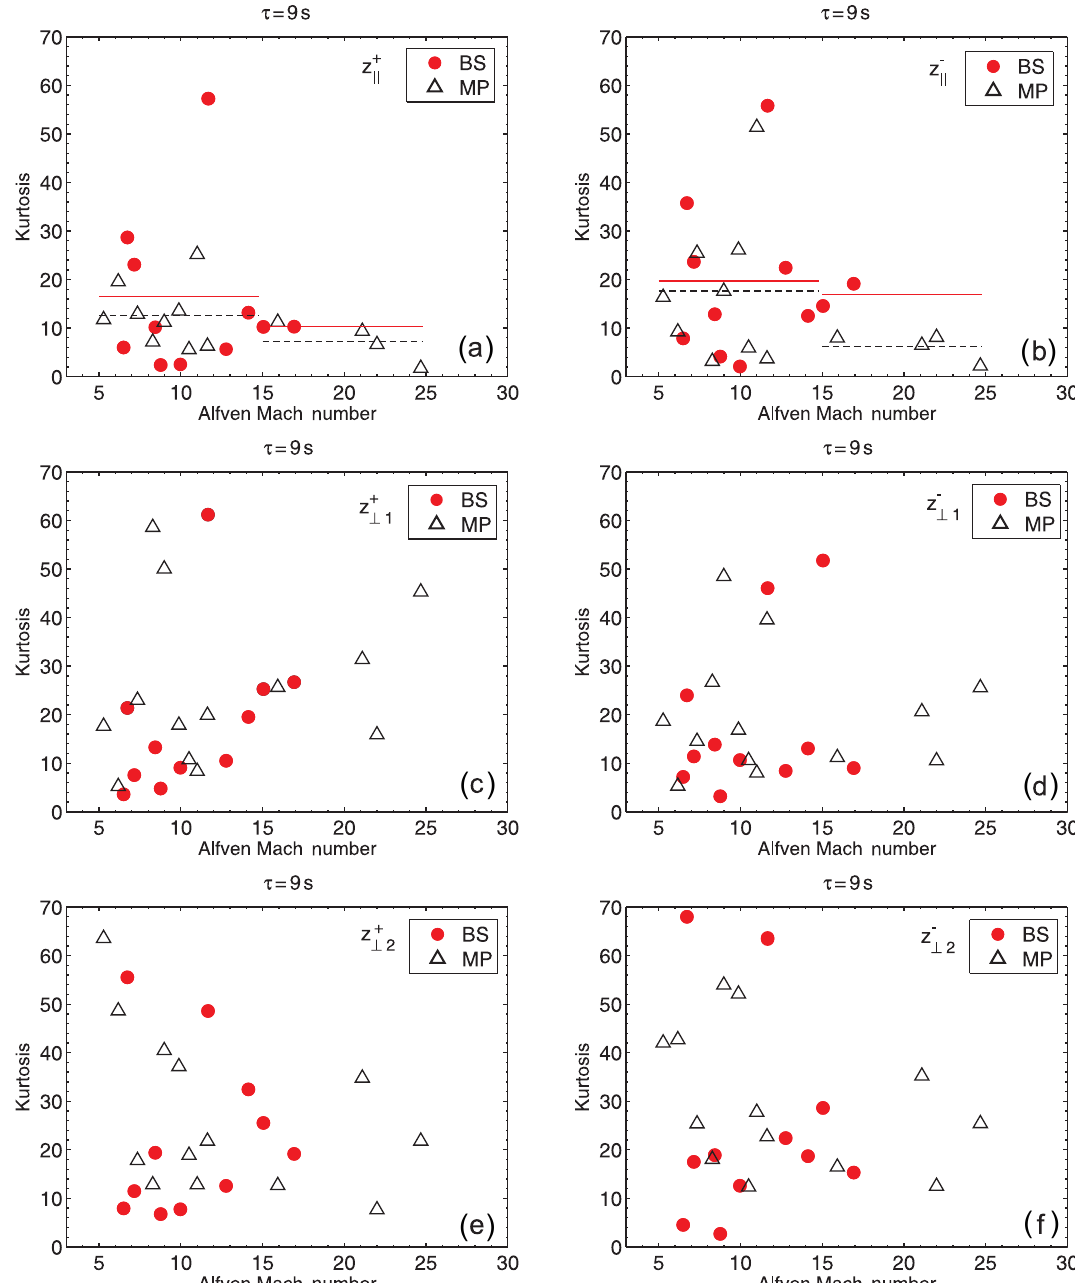
Figure 9. Kurtosis of the increments of the Elsässer vectors, δ z ± , in the magnetosheath vs. the Alfvén Mach number for the components δz ± (cid:107) (parallel to the mean field vector B o , panels a and b ) and two components perpendicular to the field: (1) δz ± ⊥ (in the plane containing B o 1 and the X axis in the GSE system, panels c and d ), and (2) δz ± ⊥ (perpendicular to the plane, panels e and f ) near the bow shock (BS, red 2 circles), with averages marked by a continuous line, and near the magnetopause (MP, white triangles), marked by dashed lines, as observed by THEMIS for samples listed in Table